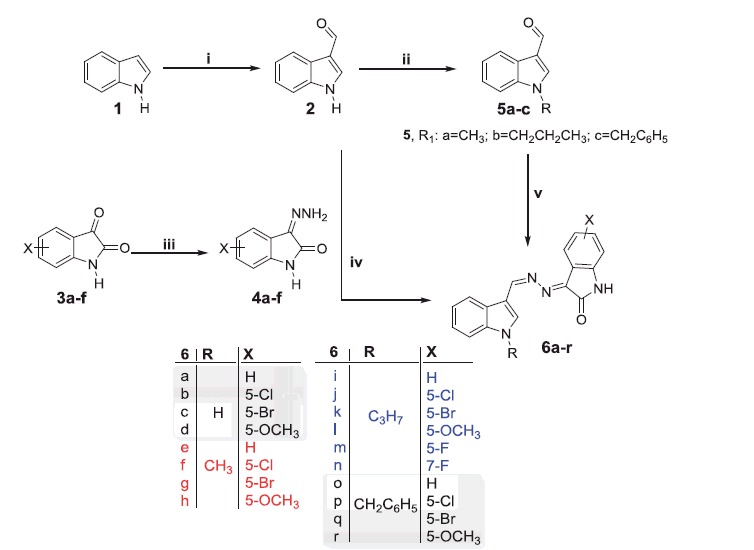
Synthesis of target compounds 6a–r; Reagents and conditions: (i) dry DMF/POCl3/NaOH/H2O/2 h, (ii) alkyl (or benzyl) bromide/THF/NaH, r.t. 12 h, (iii) CH3OH/NH2NH2.H2O/reflux 1 h, (iv) EtOH/AcOH (catalytic)/reflux 3 h and (v) Hydrazones 4a–d/EtOH/AcOH (catalytic)/reflux 3 h.